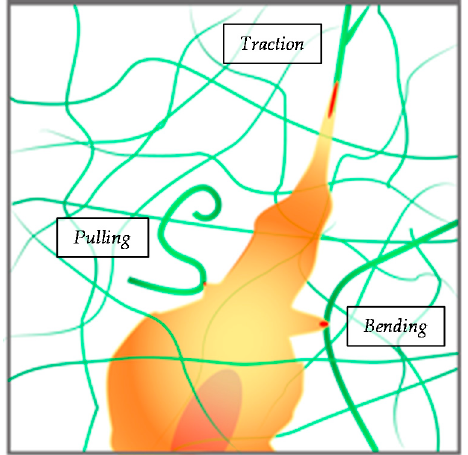
Figure 3. Cell perception of mechanical cues in 3D fibrillar gels. Cells might receive very different mechanical feedbacks from the surroundings according to the local configuration of the matrix. High traction forces are required for direct fibril traction, whereas low forces are necessary for fibril bending or pulling slack fibrils. Focal adhesion (FA) length and composition change accordingly.